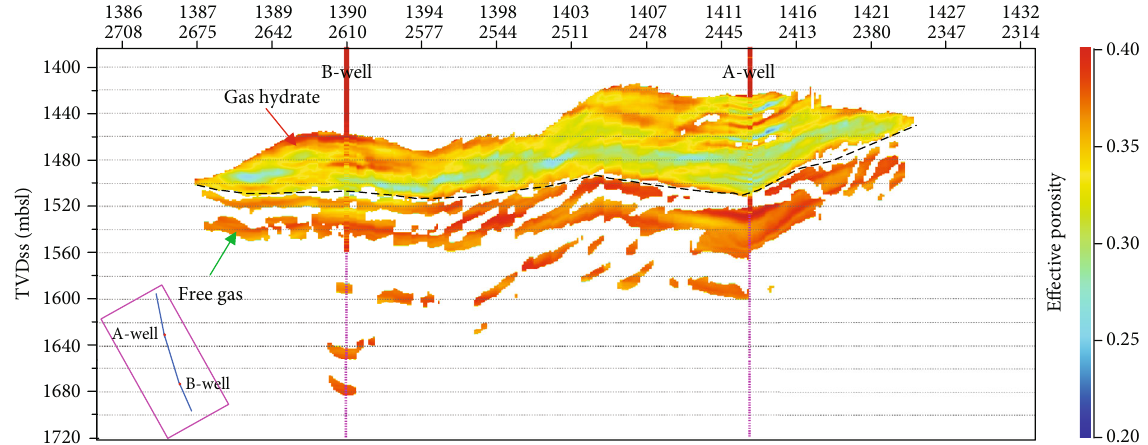
Figure 14: Well-tie e ff ective porosity cross section of the A-well and